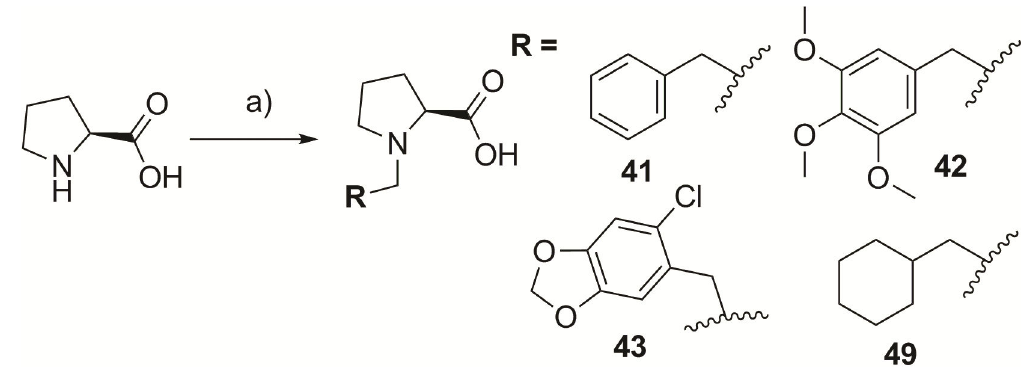
Figure 9. Synthesis of N- substituted proline derivatives. Reagents and conditions: (A) R-X, NaOMe/MeOH, 50°C, 12 h. doi: